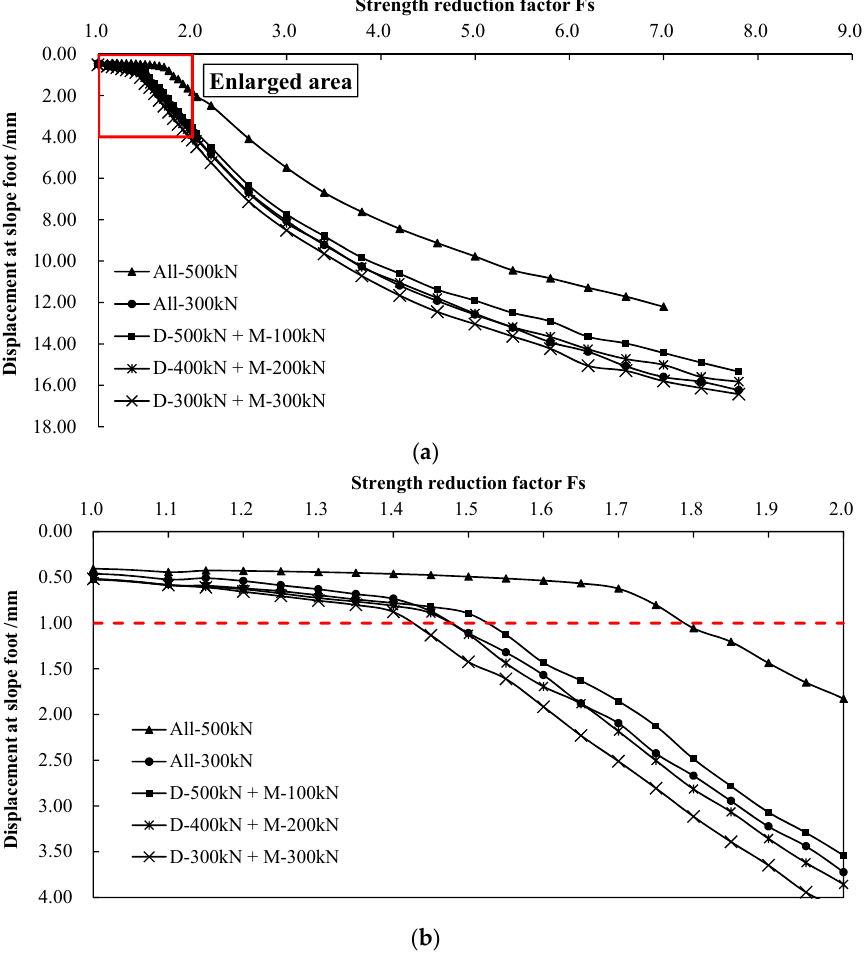
Figure 11. ( a ) The relationship between the displacement of the slope foot and the strength reduction factor under different schemes of prestressed anchor cables; ( b ) enlarged drawings of the enlarged sections in Figure 11a.